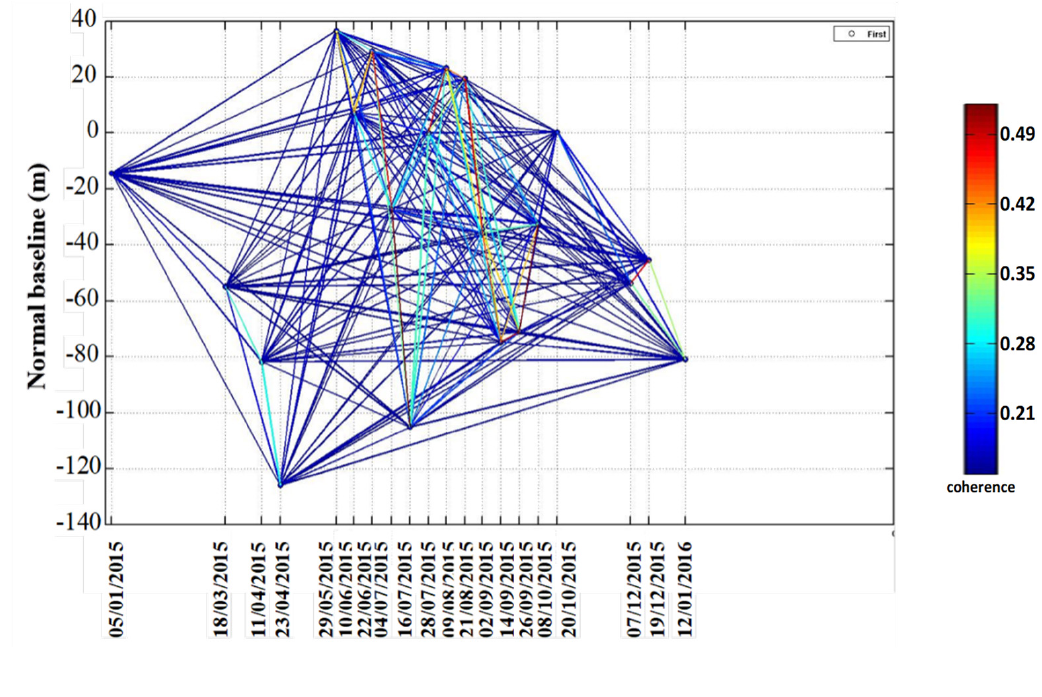
Figure 7. Full-graph Multi-Baseline Construction (MBC) method: ascending dataset. Temporal-normal baselines are coloured using a rainbow scale according to the InSAR pair coherence.